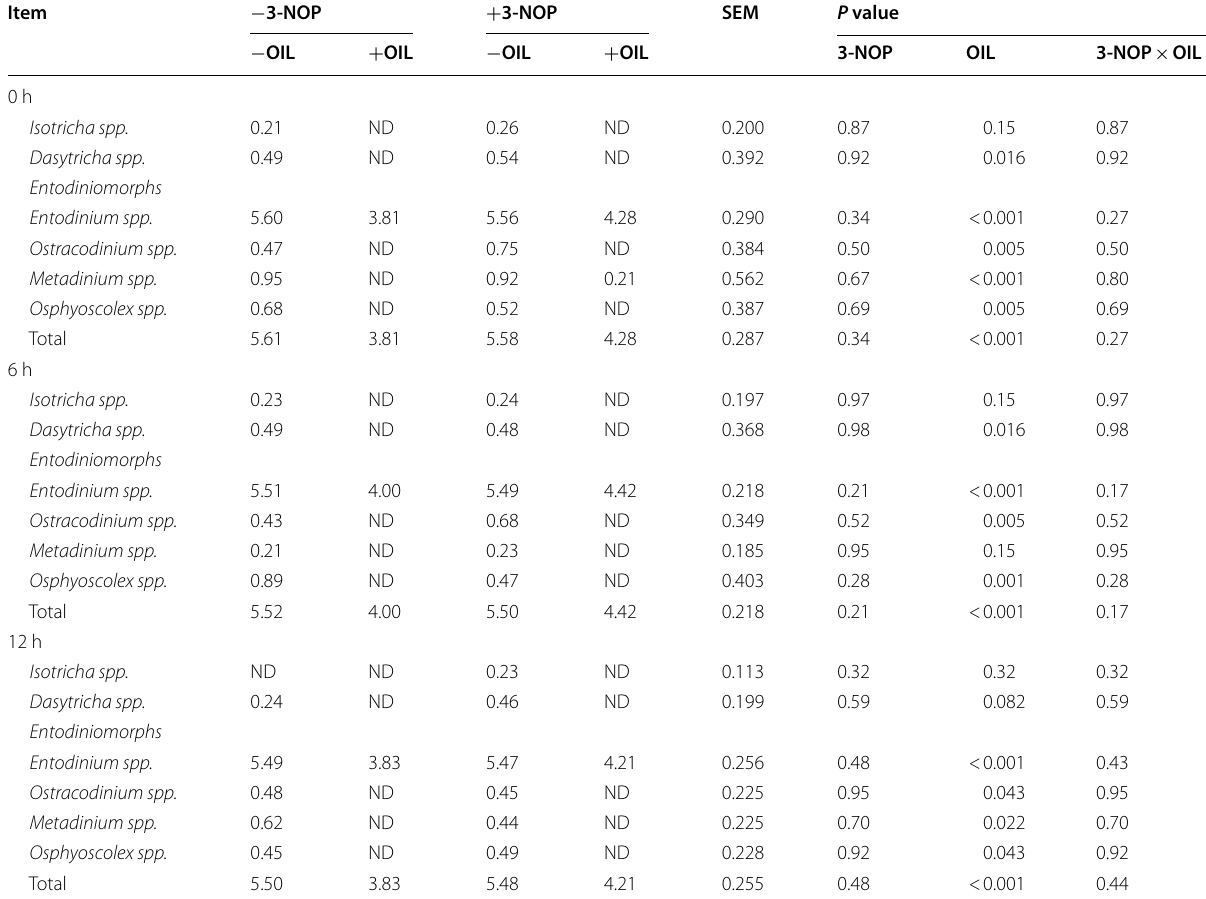
Table 4 Impact of feeding diets supplemented with ( in the rumen fluid of beef at 0, 6 and 12 h after feeding